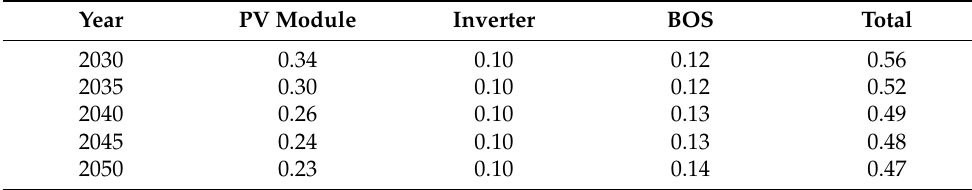
Table A10. Projection cost of 1 MW PV unit (M.USD/MW).